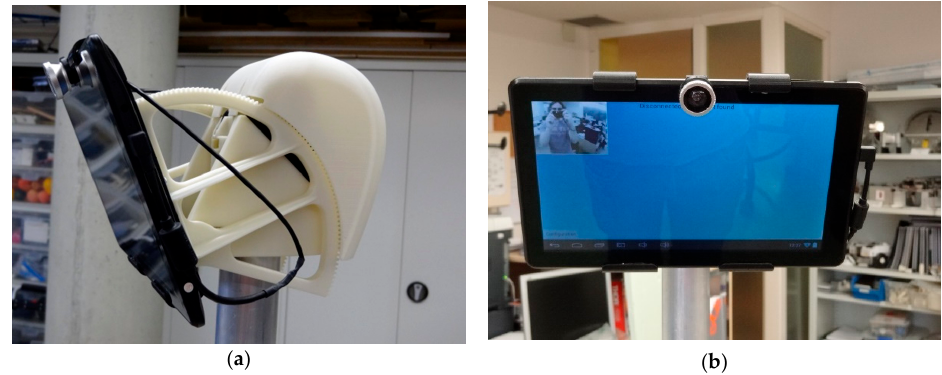
Figure 4. Detail of the head of the APR: ( a ) lateral view, ( b ) frontal view.